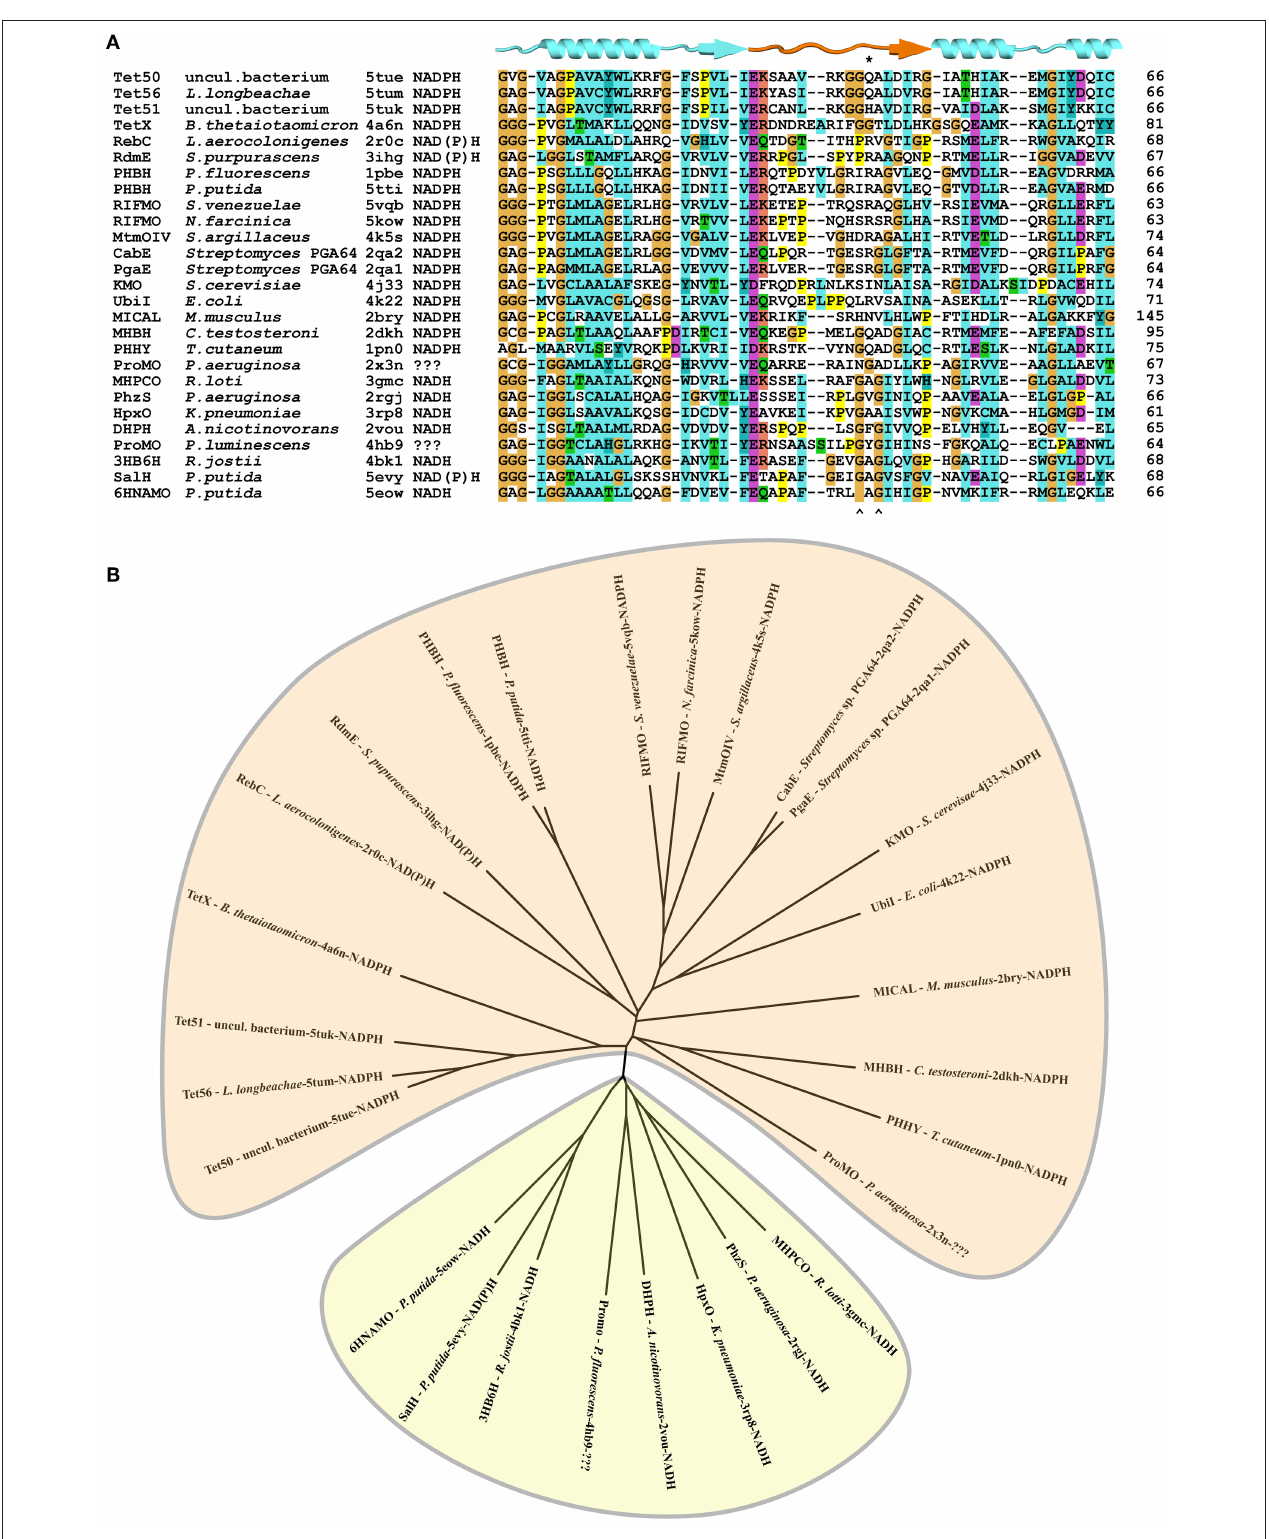
FIGURE 6 | Conservation of loop segment putatively involved in determining the pyridine nucleotide coenzyme specificity of group A flavoprotein monooxygenases. (A) Alignment of the sequences forming the loop structures putatively involved in NAD(P)H binding. Alignment of sequences was made using Clustal-X.